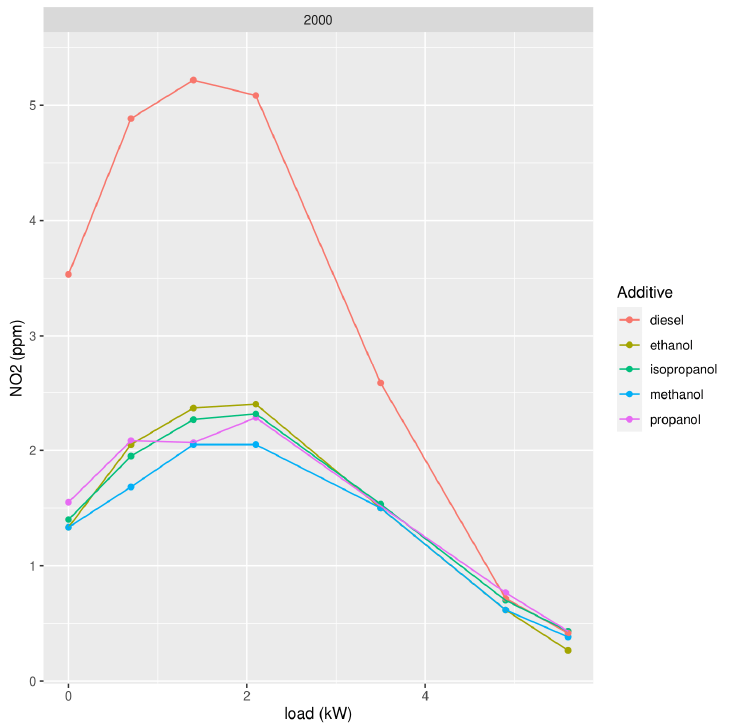
Figure 6. Concentration of NO 2 in exhaust gases in function of the power of the diesel generator after addition of 2000 ppm of methanol, ethanol, propanol, and isopropanol.